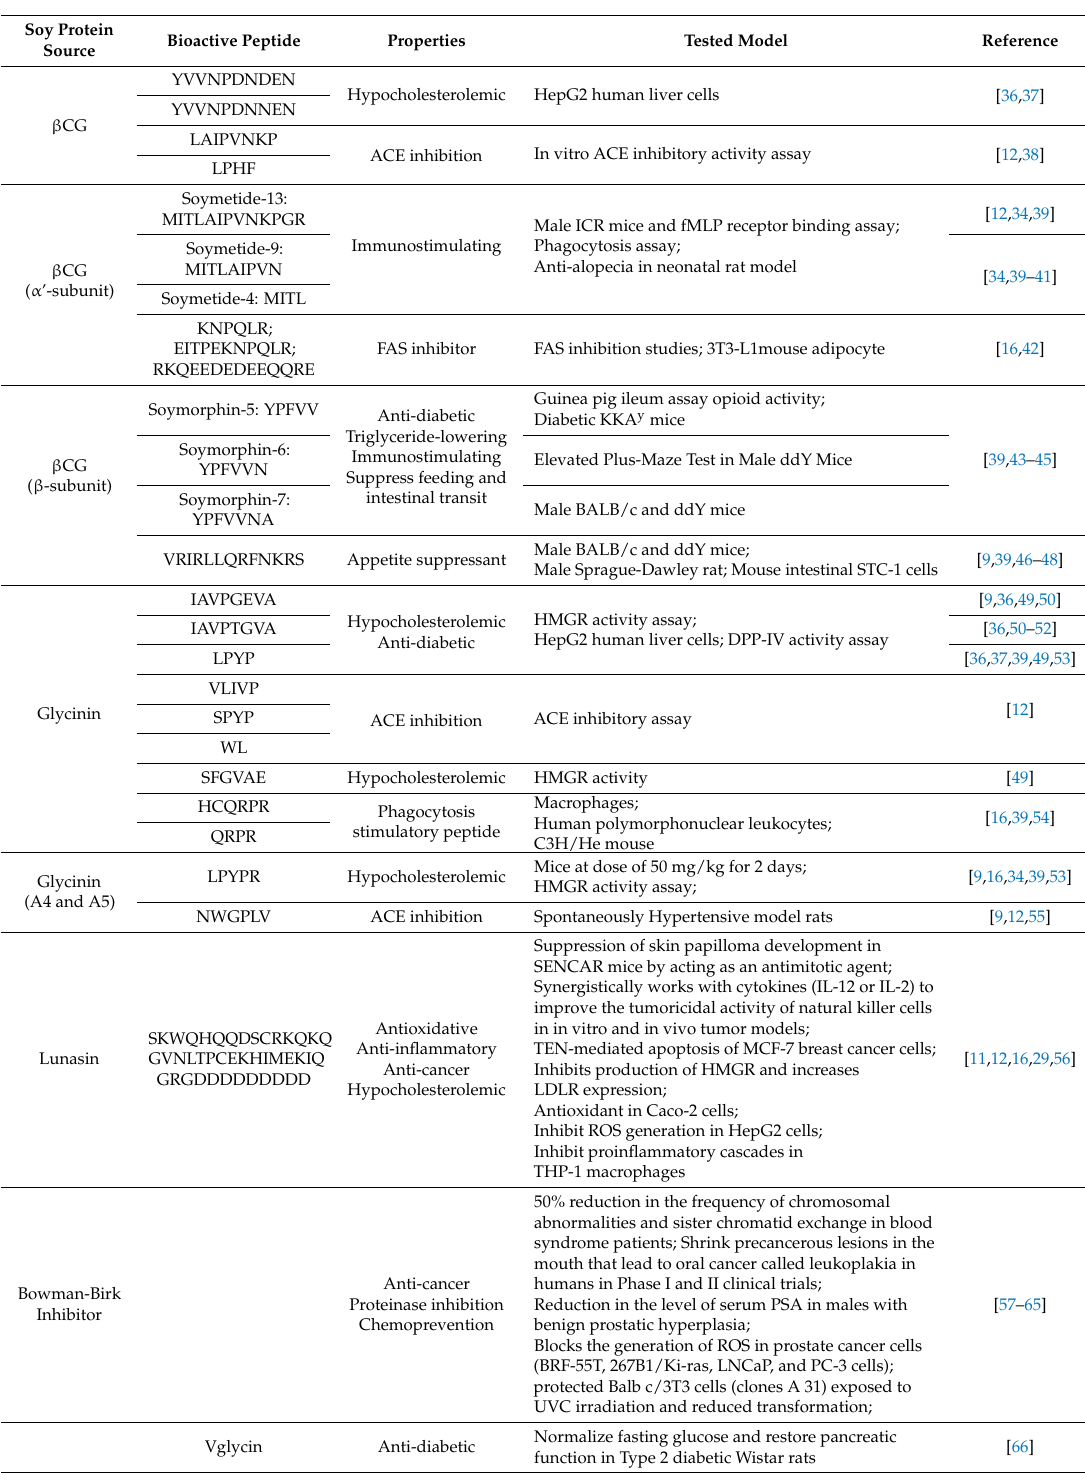
Table 1. Soy bioactive peptides and their